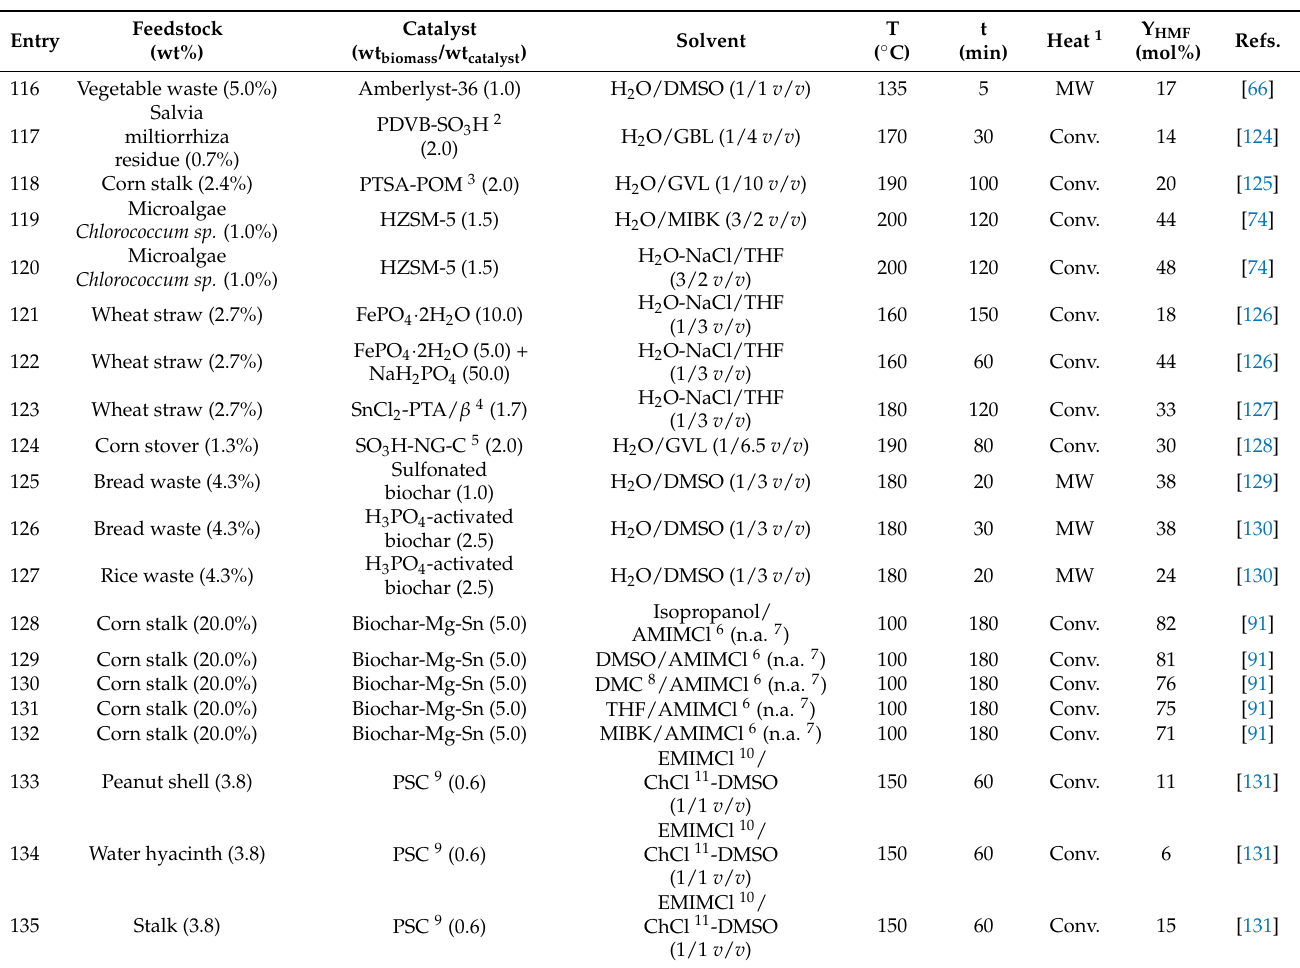
Table 5. HMF production from raw biomasses in biphasic and/or multiple-solvent systems with heterogeneous